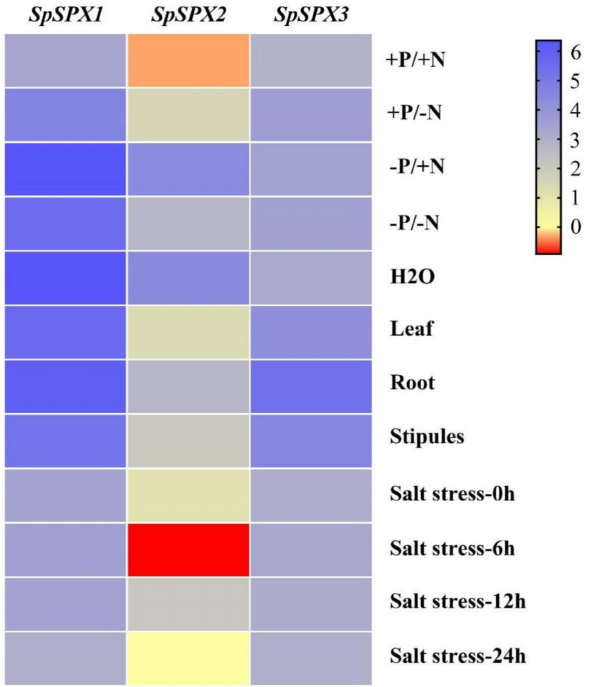
Figure 8. Expression profiles of SpSPX genes under abiotic stress conditions (P/N stress, and salt stress) and in different tissues (leaf, root, and